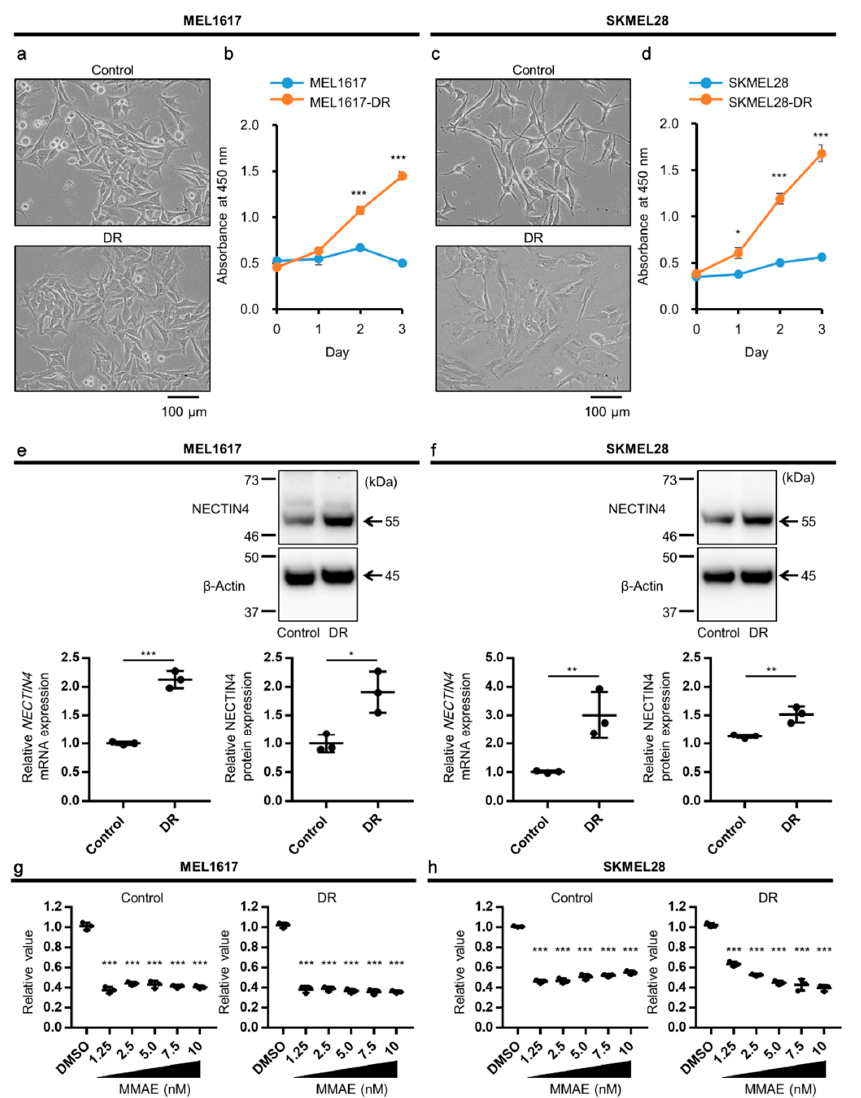
Figure 2. BRAFi-resistant melanoma cells highly express NECTIN4 and are sensitive to MMAE. ( a ) Representative images of MEL1617 (Control) and its dabrafenib-resistant (DR) cells. Scale bar = 100 µ m. ( b ) Growth curve of MEL1617 and MEL1617- DR treated with 1 µ M dabrafenib. ( c ) Representative images of SKMEL28 (Control) and its DR cell lines. Scale bar = 100 µ m. ( d ) Growth curve of SKMEL28 and SKMEL28-DR treated with 1 µ M dabrafenib. ( e , f ) The expression of NECTIN4 mRNA and NECTIN4 protein in ( e ) MEL1617 and ( f ) SKMEL28 and their DR cell lines ( n = 3). Representative gel images of NECTIN4 and β -Actin (a loading control) are shown. ( g ) MEL1617 and ( h ) SKMEL28, and their DR cell lines were treated with DMSO (0.1%) or MMAE (1.25, 2.5, 5, 7.5, or 10 nM) for 48 h and assessed for cell viability ( n = 3). Data are presented as the mean ± standard deviation of three independent experiments. * p < 0.05, ** p < 0.01, and *** p < 0.001 determined by Student’s unpaired two-tailed t